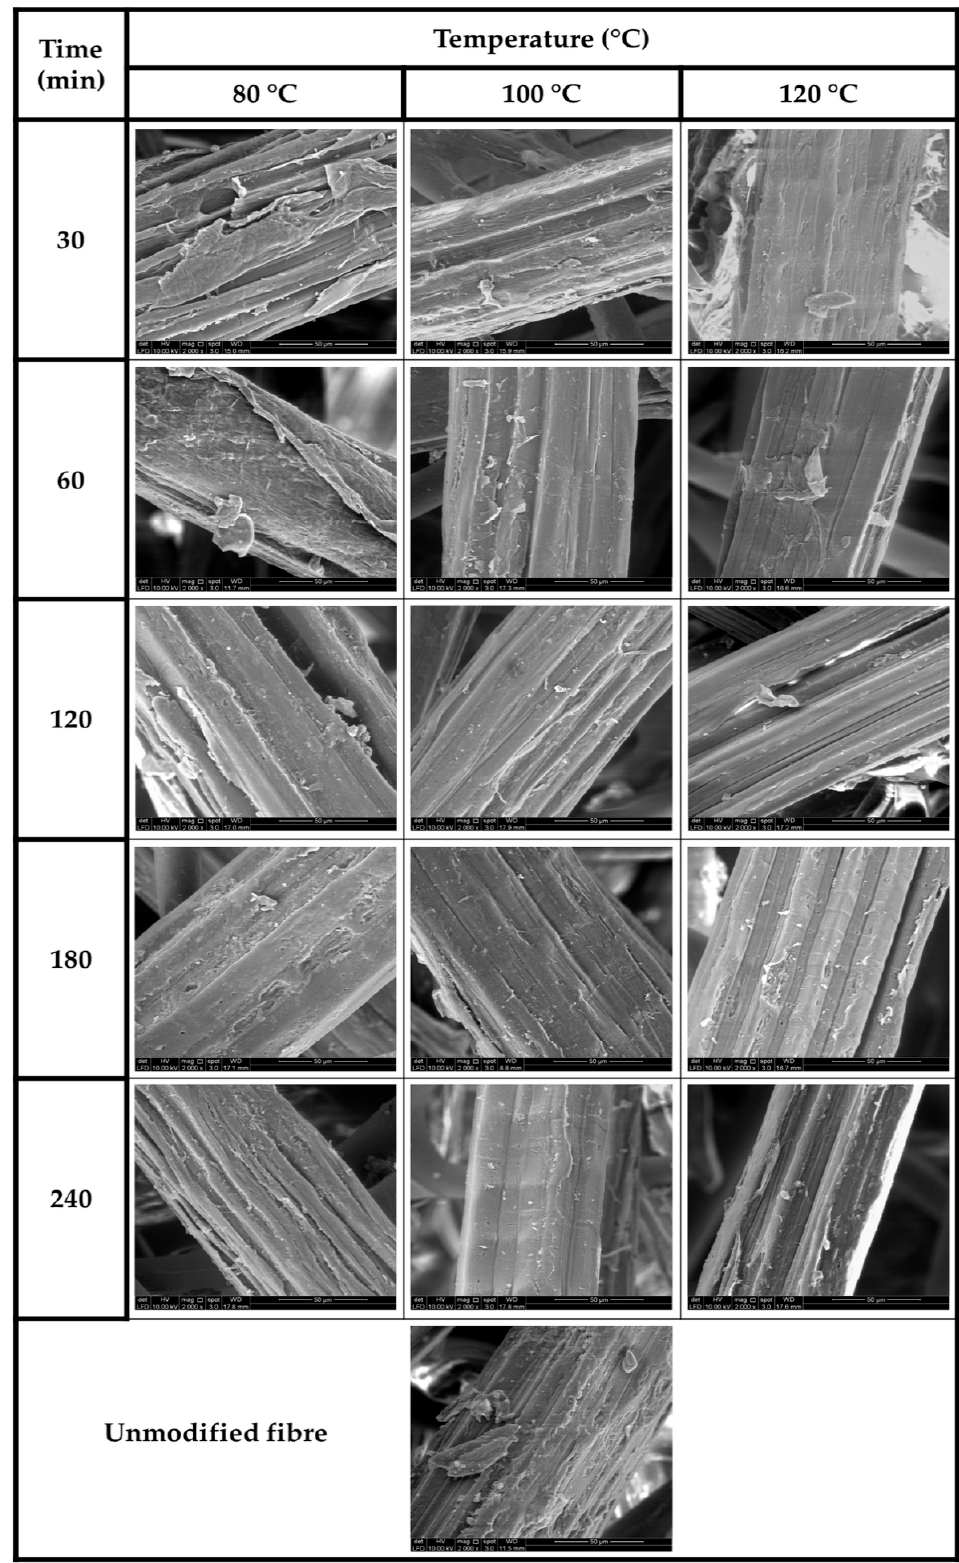
Figure 3. SEM micrographs of modified nonwoven kenaf fibre with different reaction temperature and different retention time.